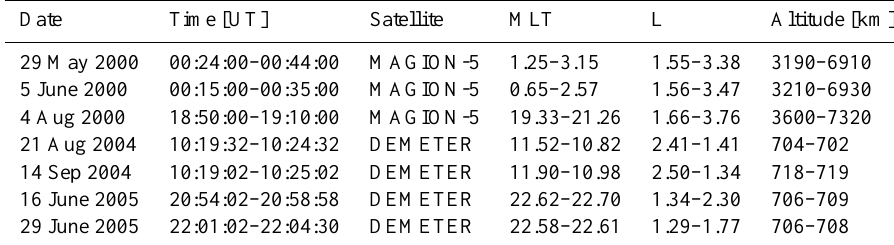
Table 1. Analysed time intervals and selected orbital parameters during the analysed periods.